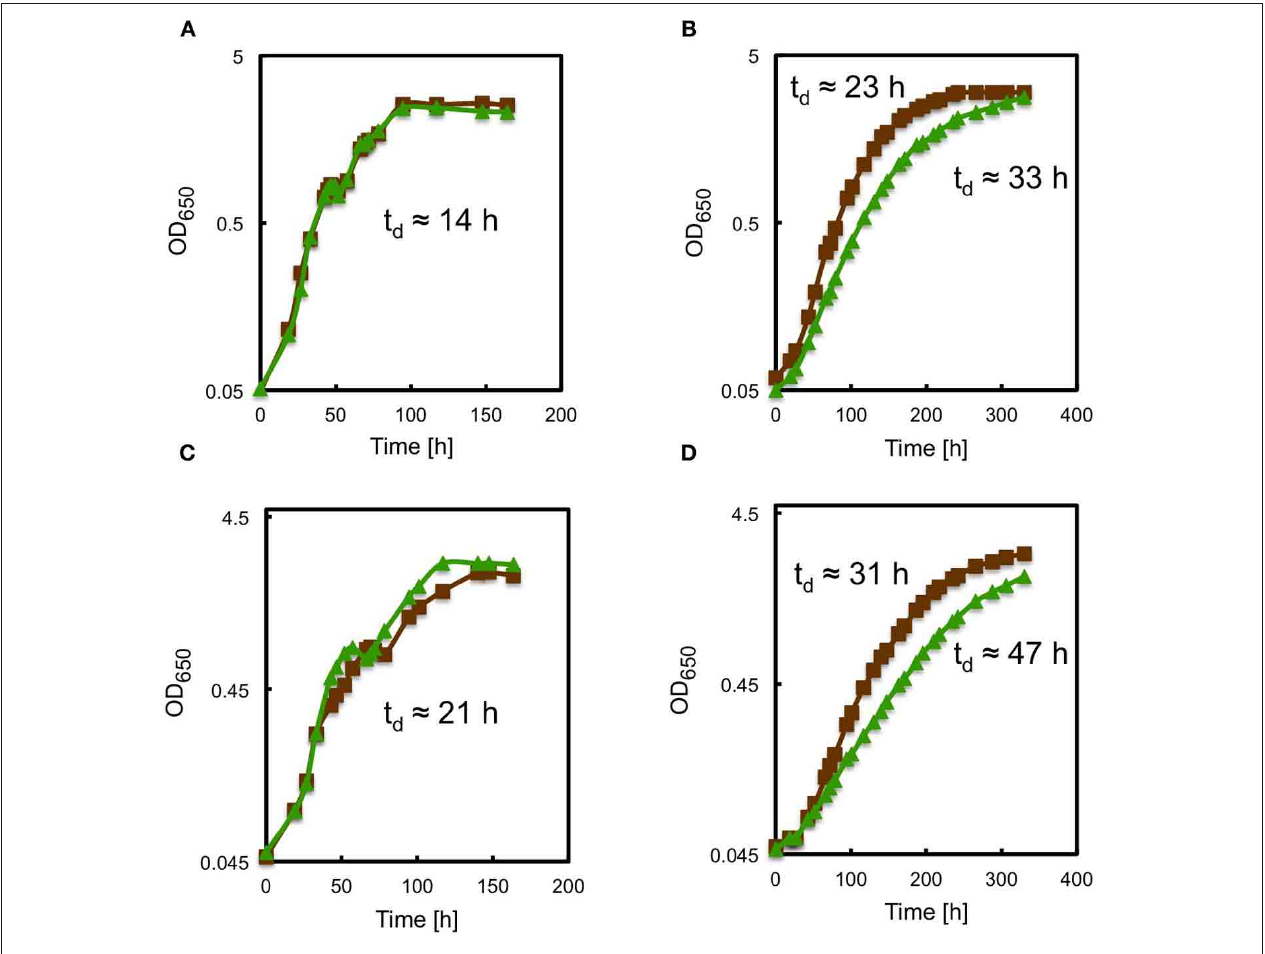
10 µ mol photons m − 2 s − 1 (panels B and D). For panels A and B , a tungsten lamp was used, and for panels C and D , cool white fluorescent lamps were used. For additional details, see